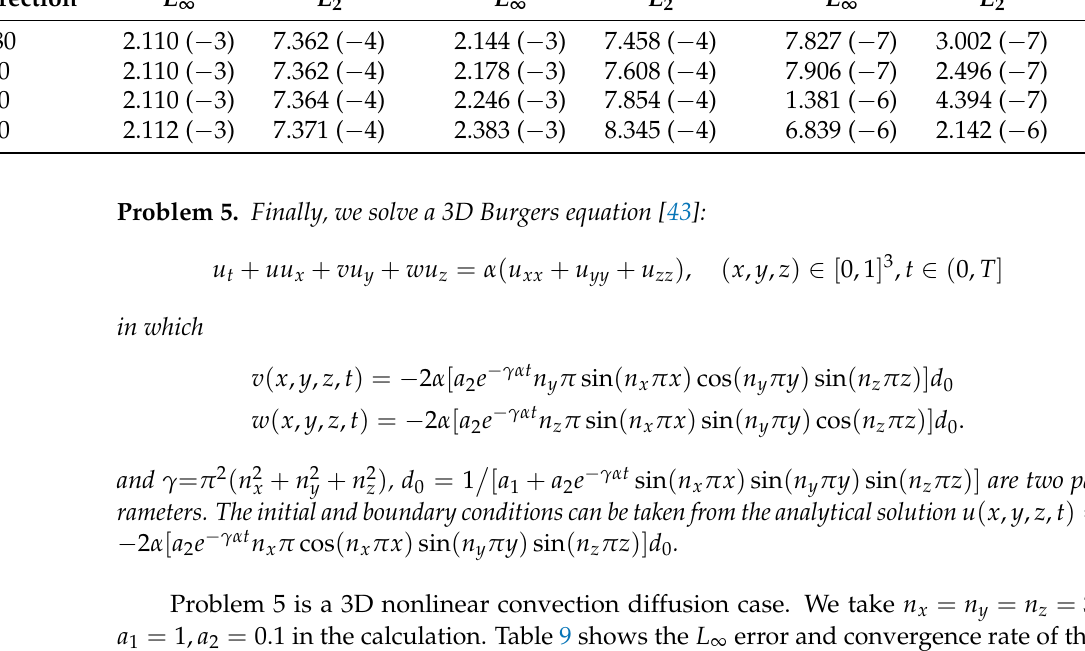
for Problem h 2